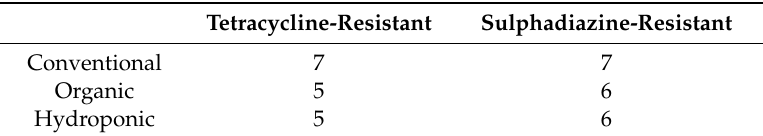
Table 1. Frequency of lettuce samples harbouring resistant bacteria 1 .